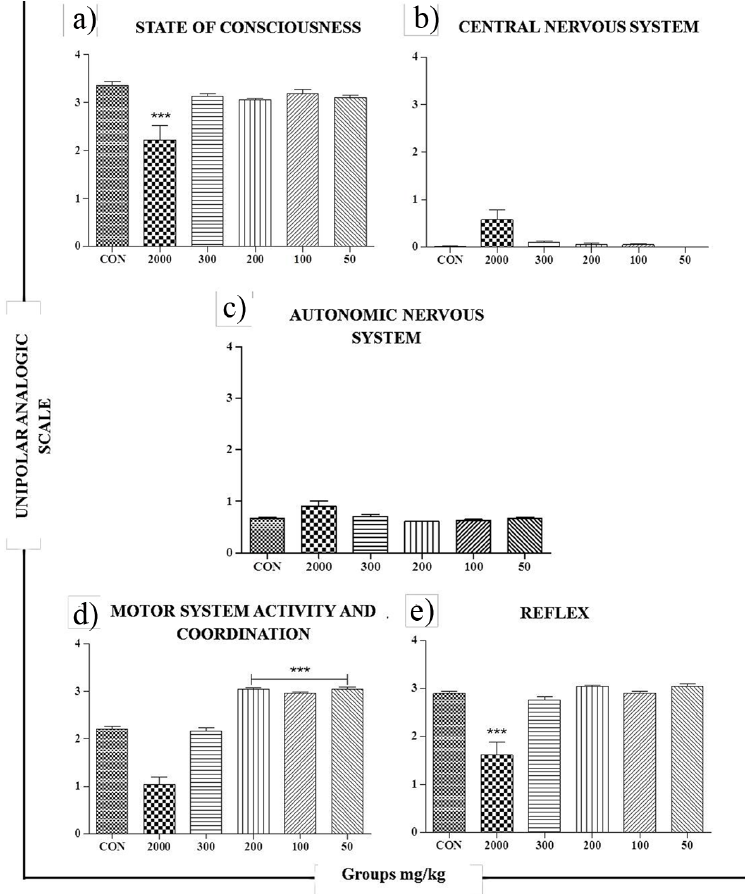
Figure 1. Hippocratic screening for behavioral evaluation of animals submitted to treatment with single dose of aqueous extract from leaves of